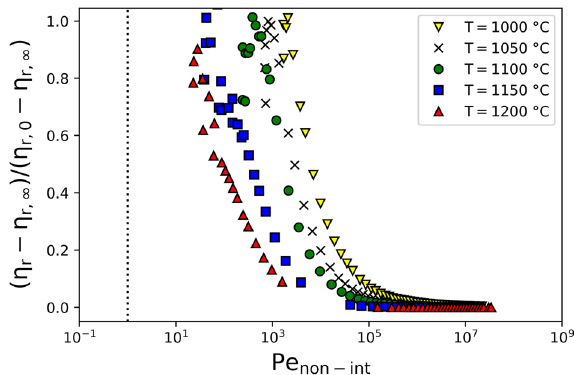
Figure 5. Normalised relative viscosity data from Hanotin et al. 17 against Pe number for non-interactive